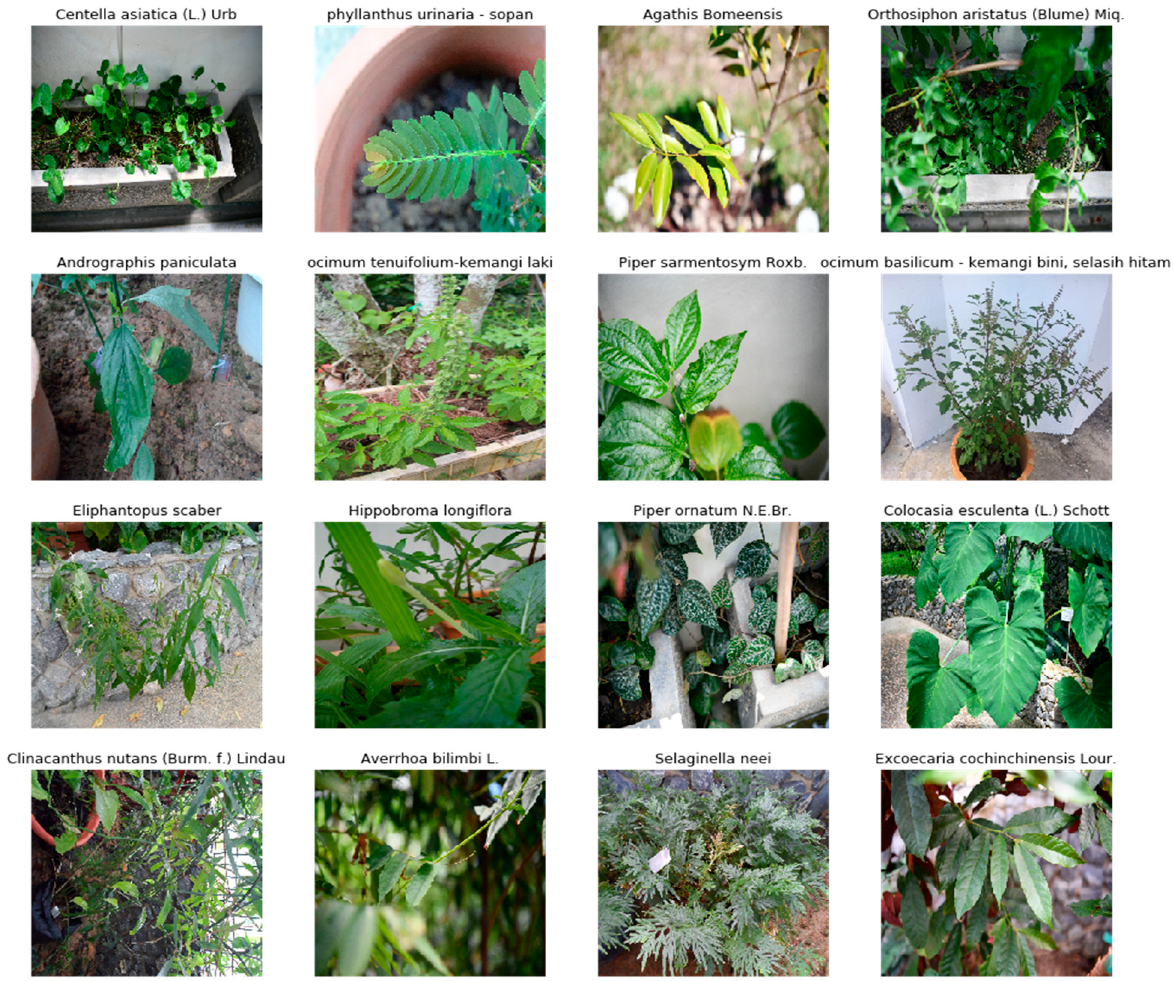
Figure 2. Image samples taken from UBD Botanical dataset.